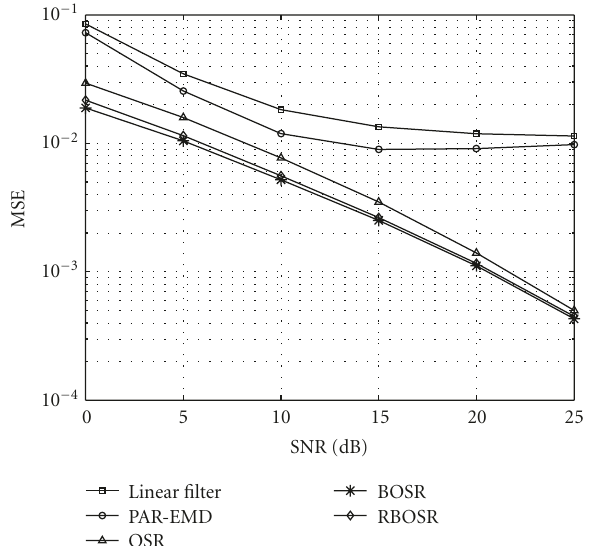
Figure 7: MSE versus SNR for three di ff erent denoising algorithms.